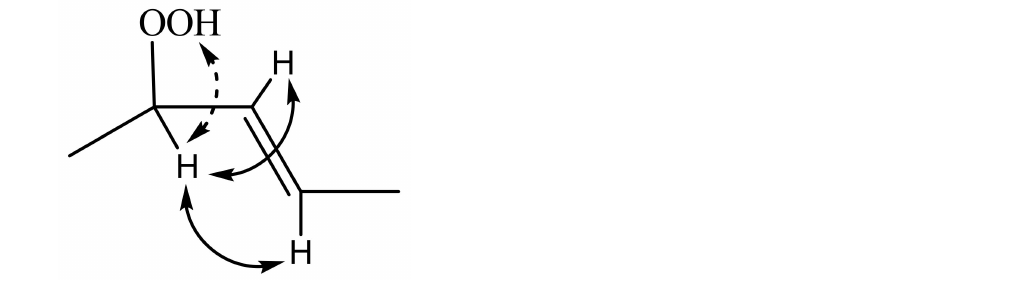
Figure 34. Signal assignment of hydroperoxides with the combined use of 1D NOE ( TOCSY ( ).